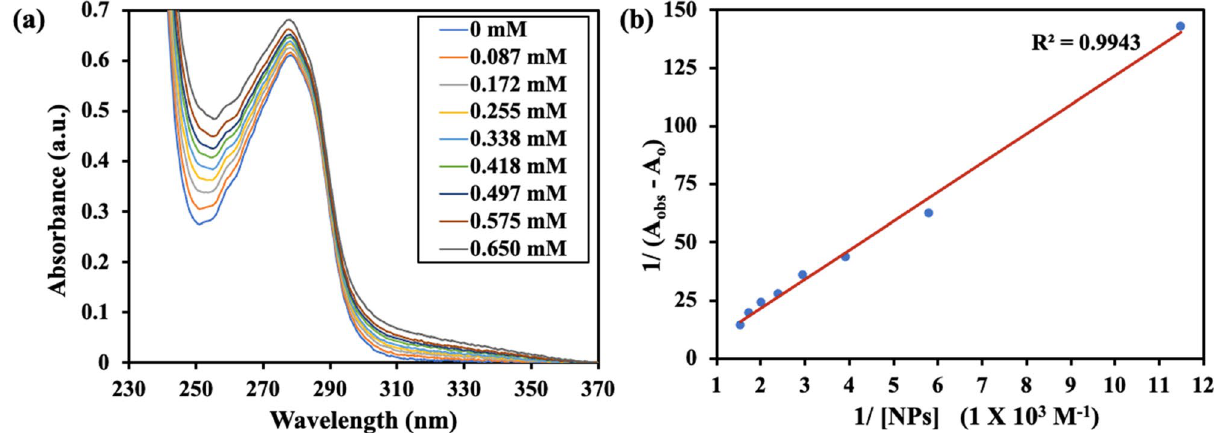
Figure 3. ( a ) Absorption spectra of BSA showing increase in absorbance values with increase in concentration of ZIF-8 NPs (in mM). ( b ) The plot of 1/(A obs − A o ) vs. 1/[ZIF-8 NPs] (Benesi–Hildebrand plot).